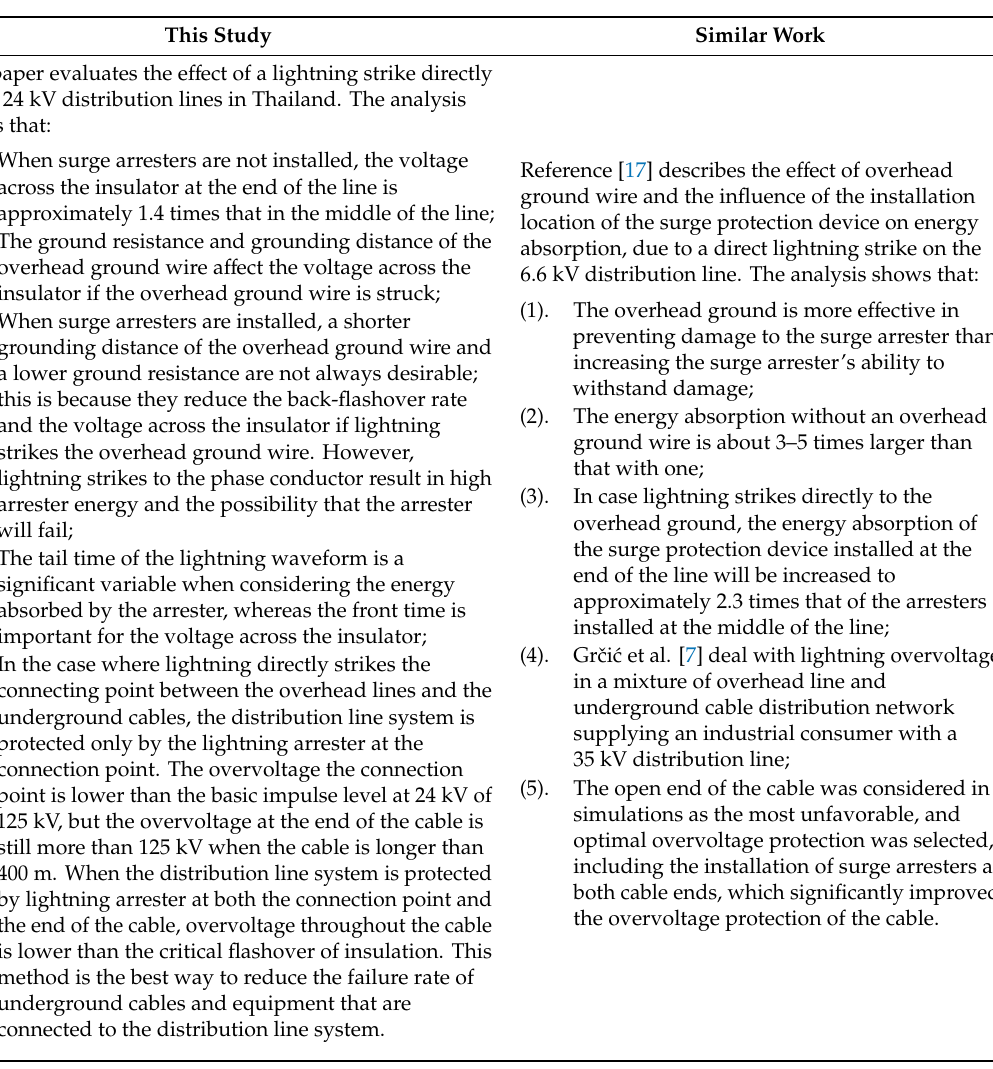
Table 2. Comparison of this study with similar